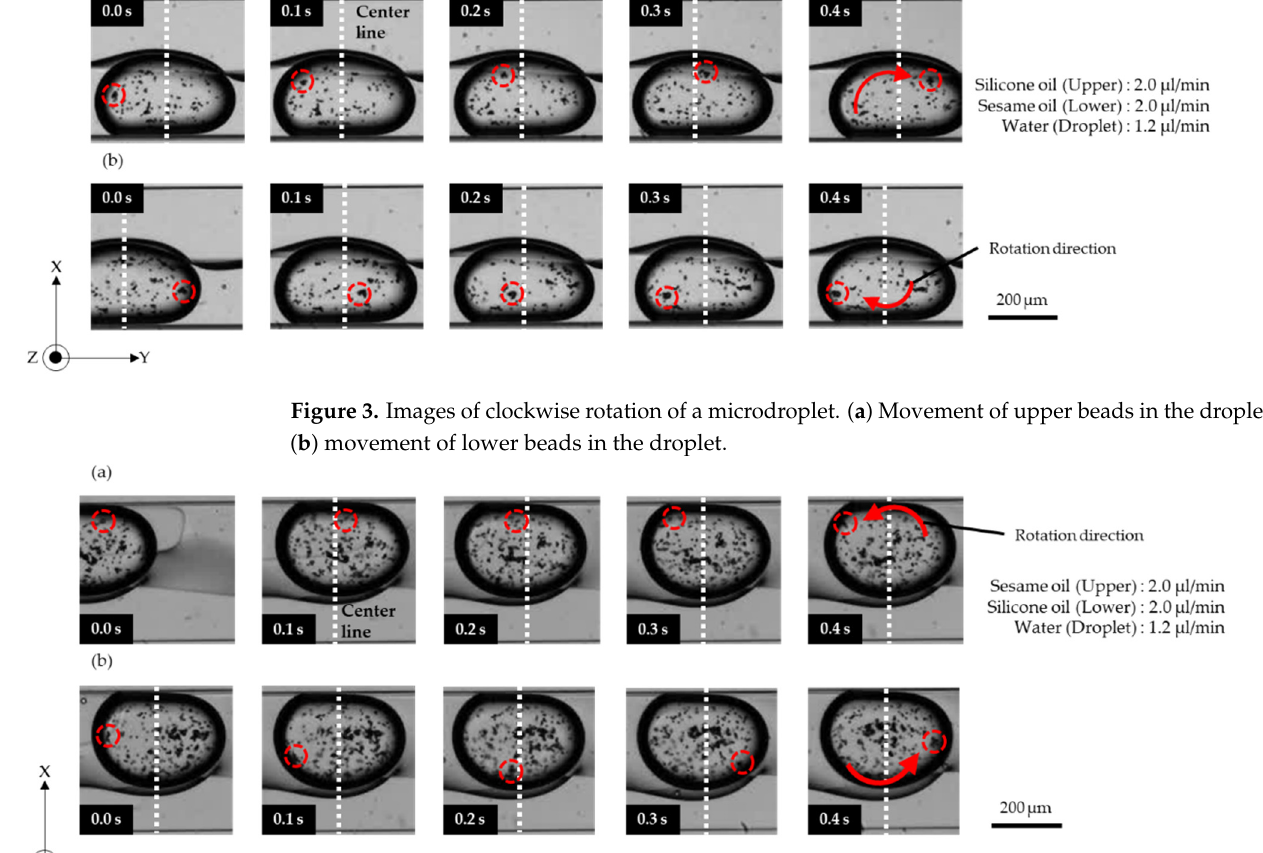
Figure 3. Images of clockwise rotation of a microdroplet. ( a ) Movement of upper beads in the drop- let; ( b ) movement of lower beads in the droplet.